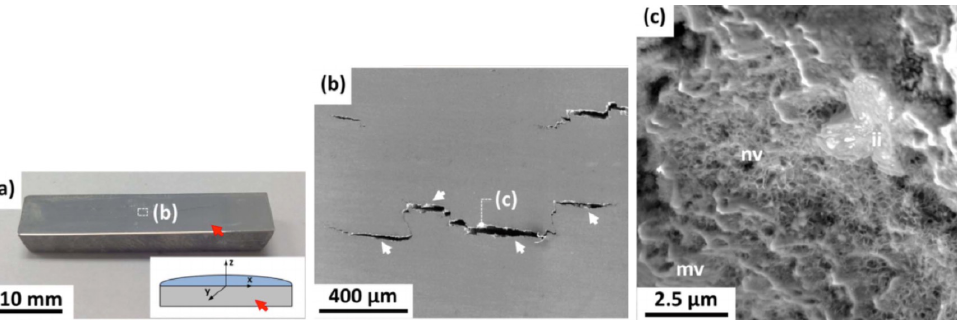
Figure 9. ( a ) Optical micrographs of the cross-sections of the recovered sample shock compressed to approximately 0.9 GPa, ( b ) SEM investigation of the damage zone showing isolated cracks within the spall plane, and ( c ) a view within the crack designated c showing micron-size or largervoid-like features (mv), nanovoids (nv), and intermetallic inclusions (ii)